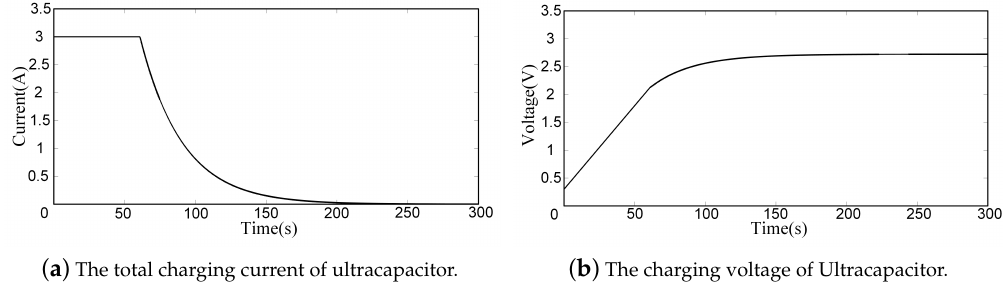
Figure 5. The total charging current and the charging voltage of ultracapacitor.